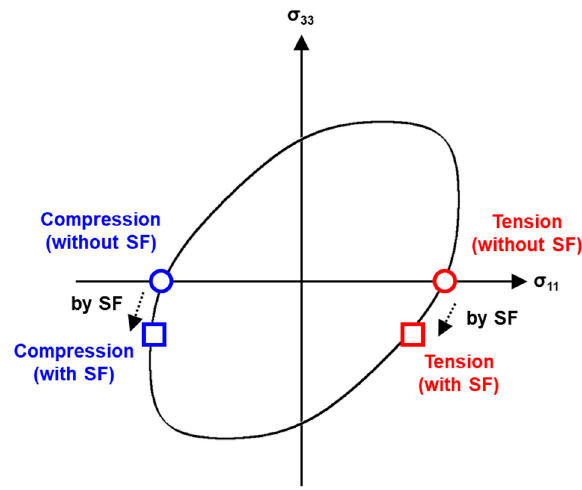
Figure 9. Schematic representation of the biaxial effect.